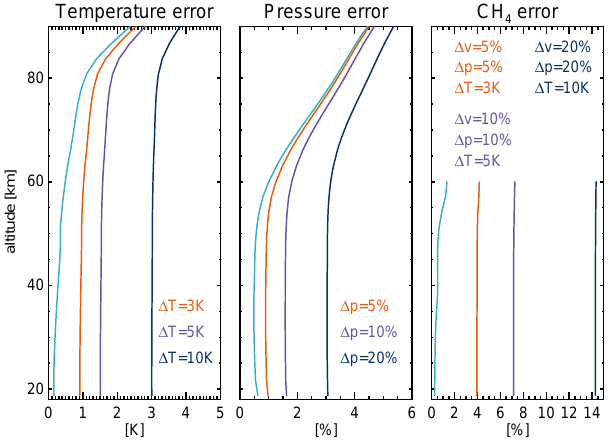
Fig. 13. Error estimates for pressure, temperature and CH 4 concen- tration. Aqua lines show the random errors, while orange, purple and blue lines show the sum of the random errors and the linear approximation errors for different deviations between the retrieved profile and the linearisation point. The random errors correspond to estimates for midlatitude conditions, but other conditions are simi-